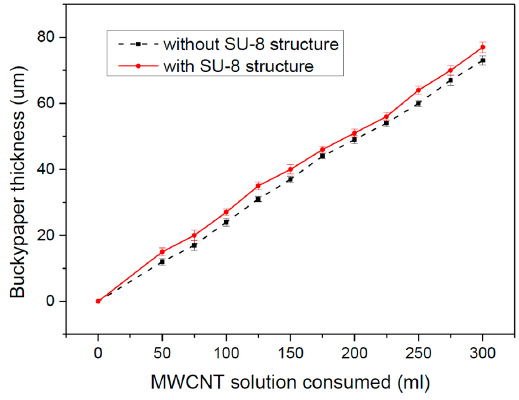
Figure 3. Thickness of buckypaper vs. consumption of MWCNT solution.